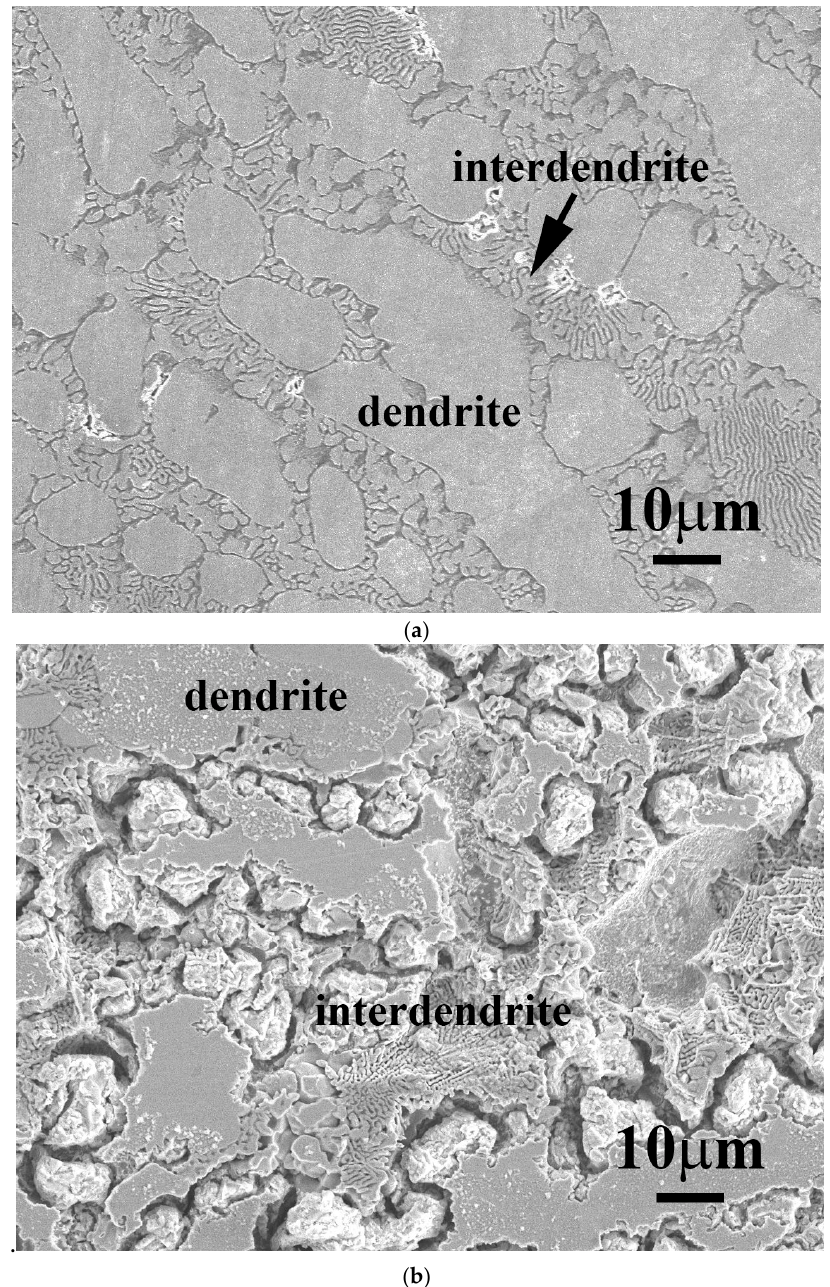
Figure 7. SEM micrographs of the alloys after polarization test in 1 M deaerated NaCl solution at 30 °C, ( a ) FeCoNiNb 0.5 Mo 0.5 alloy; and ( b ) FeCoNiNb alloy.